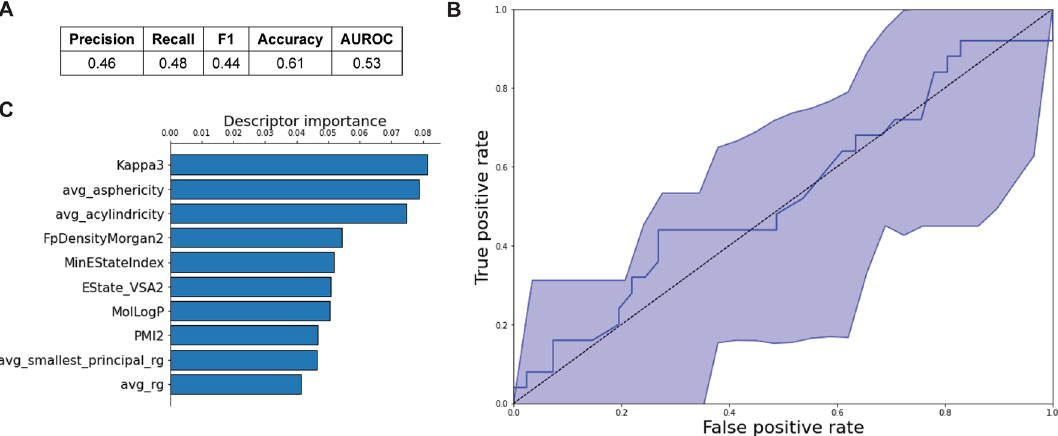
Figure 5. Random forest model performance metrics and diagrams. ( A ) Performance metrics, ( B ) ROC curve derived from leave-one-out cross validation with 95% confidence bands, ( C ) Importance bar plot of top ten features.